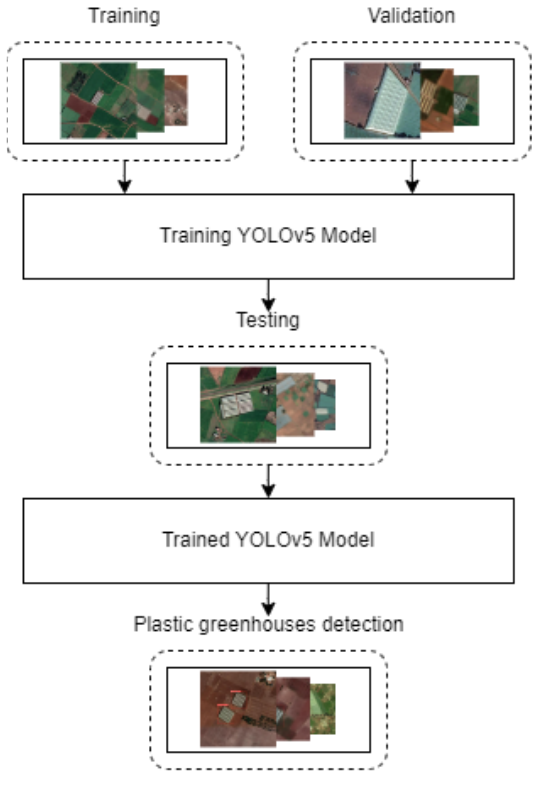
Figure 2: The study’s methodology